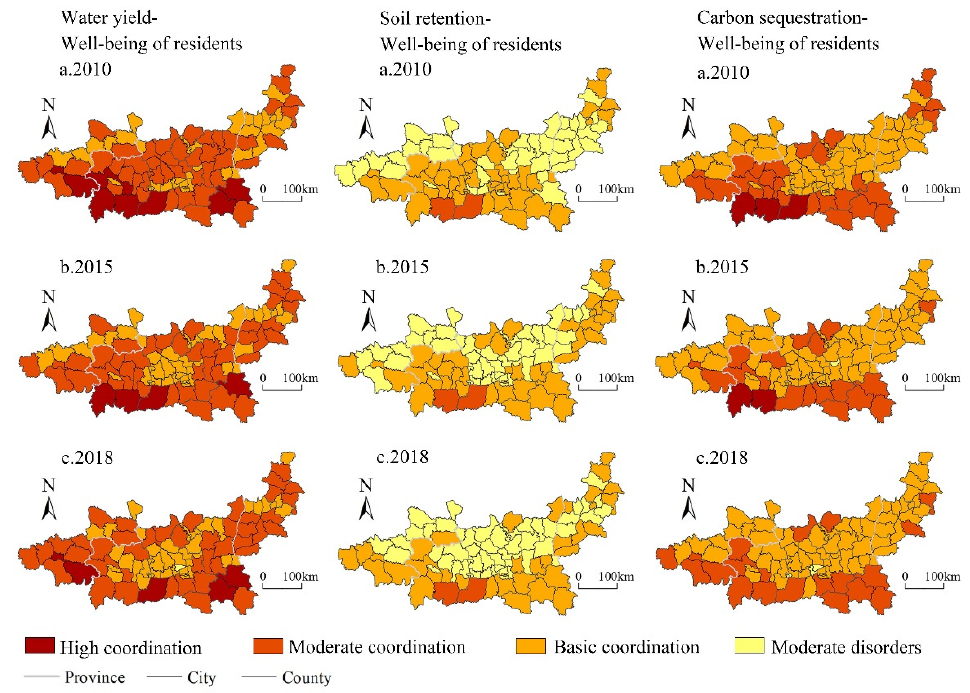
Figure 8. Spatiotemporal coupling patterns of water conservation, soil conservation, carbon seques- tration, and human well-being in Guanzhong Plain urban agglomeration from 2010 to